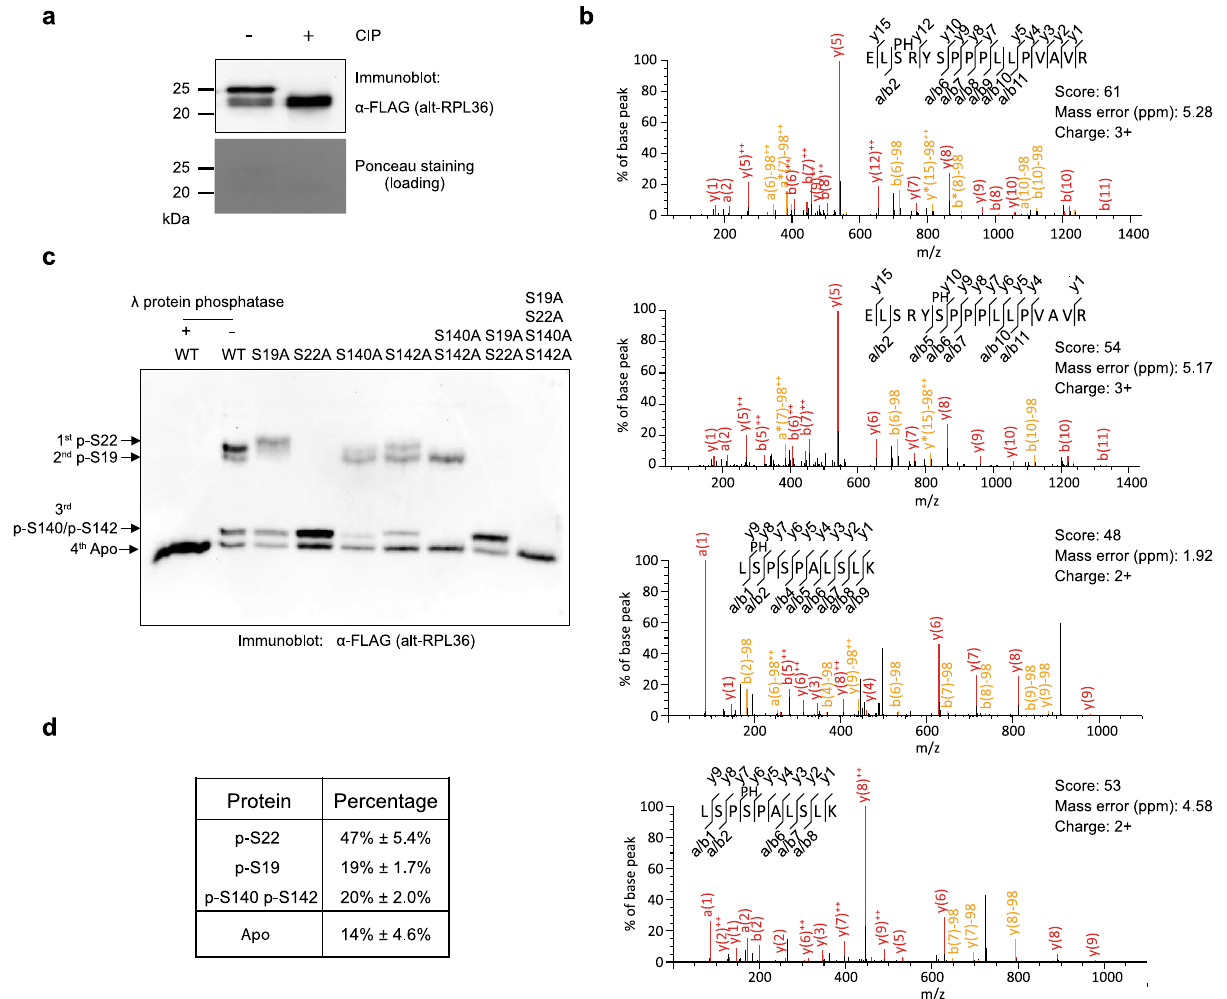
Fig. 3 Four serine residues of alt-RPL36 are phosphorylated. a Western blot analysis of immunoprecipitated alt-RPL36-FLAG-HA protein treated with calf intestinal alkaline phosphatase (CIP) and untreated control run on an SDS-PAGE gel. Ponceau staining served as a loading control. Data are representative of three biological replicates. b MS/MS spectra of alt-RPL36 phosphopeptides. S(PH) denotes phosphoserine. See Supplementary Data 2 for complete phosphoproteomics data. c To con fi rm phosphoserine assignments from MS/MS, wild-type alt-RPL36-FLAG, or alanine point mutants, were immunopuri fi ed from HEK 293T cells, resolved with Phos-tag SDS-PAGE, and detected with anti-FLAG antibody via western blot. A sample of wild-type alt- RPL36-FLAG was treated with λ protein phosphatase before Phos-tag SDS-PAGE (lane 1). Data are representative of three biological replicates. d Quantitative analysis of the western blot signal of wild-type alt-RPL36-FLAG. Data represent mean values± standard error of the mean (s.e.m.) of three biological replicates. Source data are provided as a Source data fi Supplementary Fig. 6d, e, the phosphorylation pattern of alt- RPL36 changed within 15 min of thapsigargin treatment, indicating that phosphorylation of alt-RPL36 is dynamically regulated by cytosolic calcium.